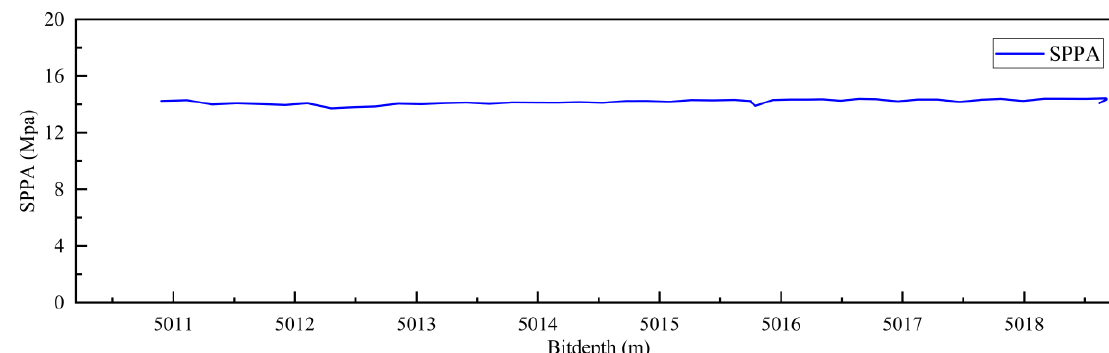
Figure 14. Circulation data for well N.